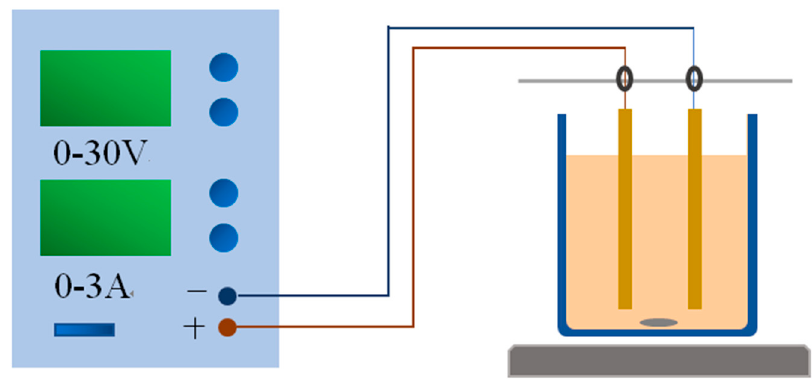
Figure 1. Electrolysis setup.